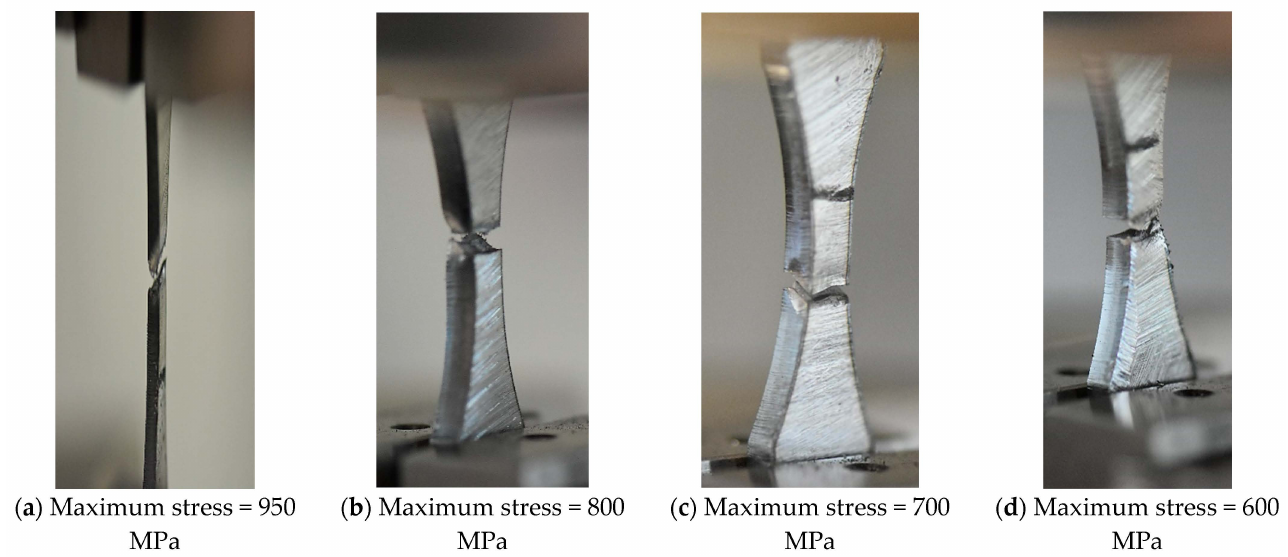
Figure 11. Fracture zones of S700MC steel welded at supporting the micro-jet cooling technique at various values of maximal stress after fatigue test, i.e. ( a ) 950 MPa, ( b ) 800 MPa, ( c ) 700 MPa and ( d ) 600